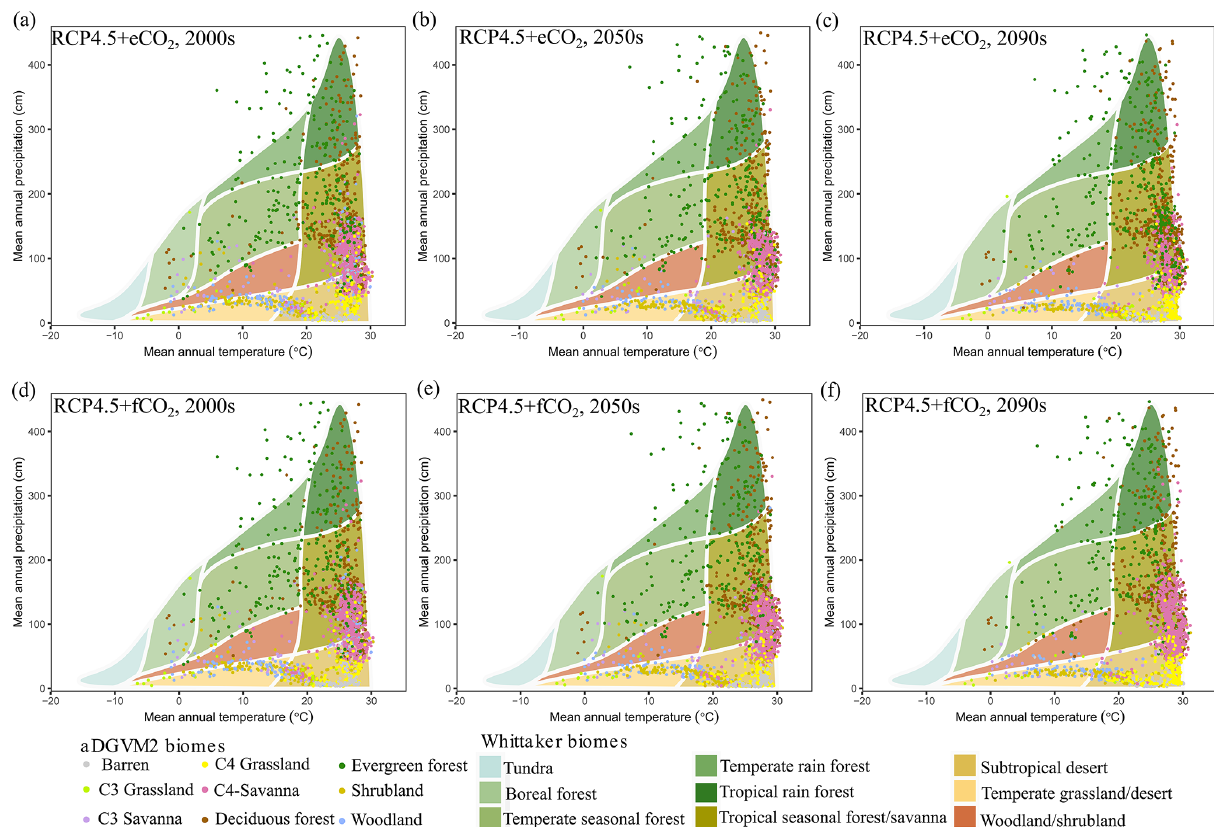
Figure 7. Simulated climate niches of biomes for the (a) 2000s, (b) 2050s and (c) 2090s under RCP4.5 + e CO 2 and (d) 2000s, (e) 2050s and (f) 2090s under RCP4.5 + f CO 2 . The simulated biomes are overlaid on the climate envelopes of Whittaker’s biomes and are plotted following Ricklefs (2008) and Whittaker (1975). See Fig. S9 for projected change in climatic niches of biomes under